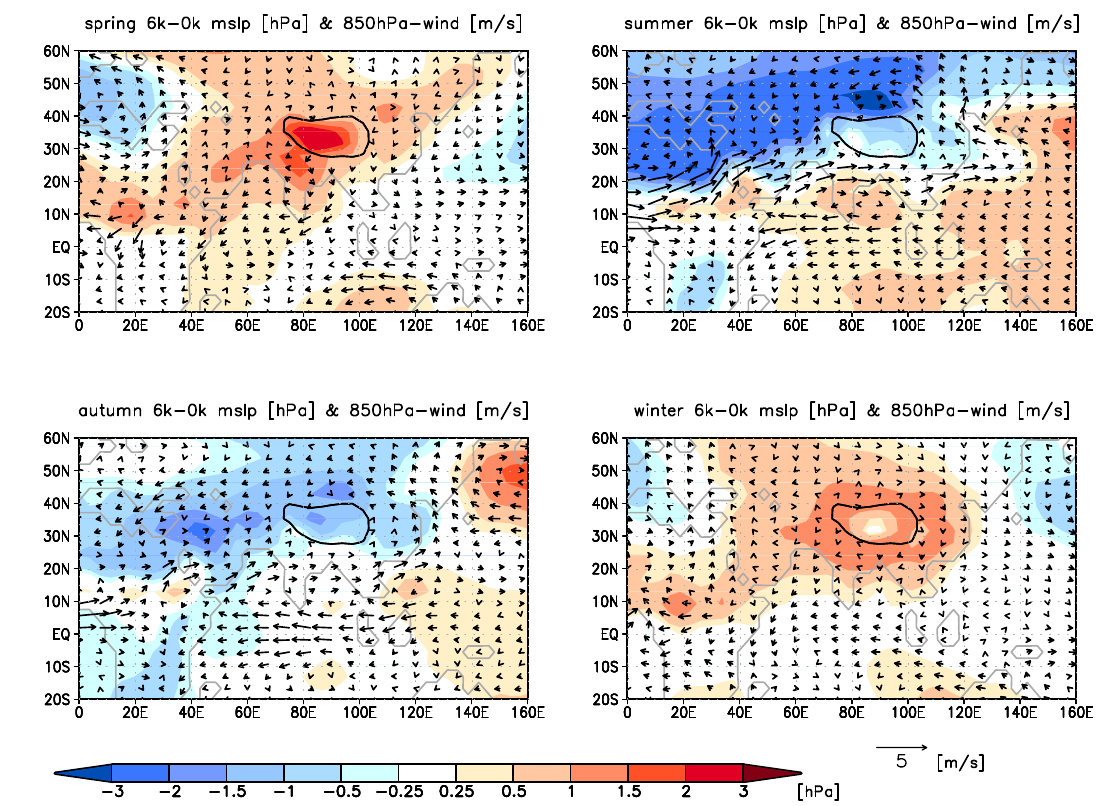
Fig. 9. Mean sea level pressure (shaded, [hPa]) and wind in 850hPa (vector, [m/s]) as simulated by the atmosphere-only run. Presented are anomalies between mid-Holocene and present-day climate on average over each season. Simulated present-day summer monsoon wind field (A 0k ) can be seen in the Appendix (Fig. A3). The black solid line marks the Tibetan Plateau (orography in the model higher than 2500m). No wind vectors are shown, where the orography in the model exceeds 1500m (approx. corresponding to the 850hPa-Niveau).